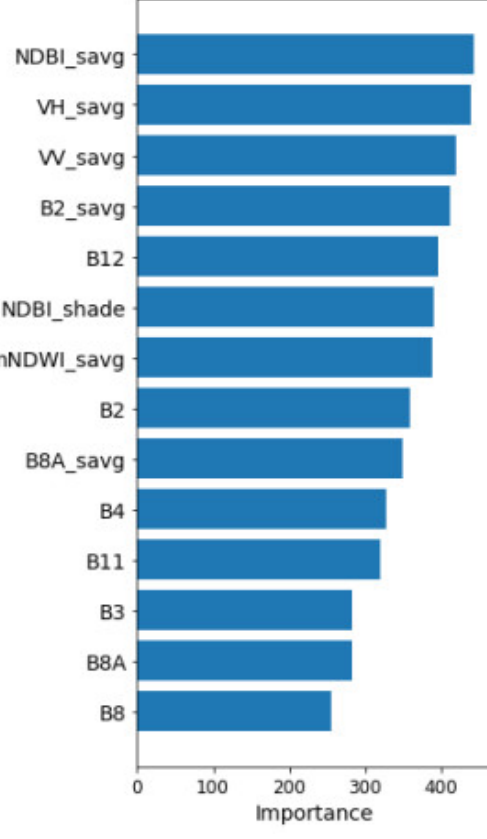
Figure 6. The importance of the 14 selected features in the RF classification.